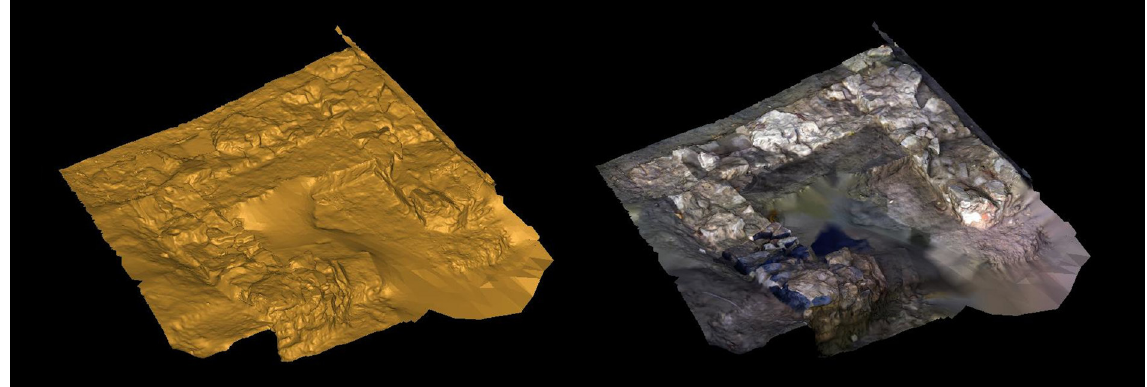
Fig. 3.37. Excavation site scanned with the Gotcha infrared sensor. On the left is the site without texture, on the right with texture. The excavation site pictured measures approximately 4×4